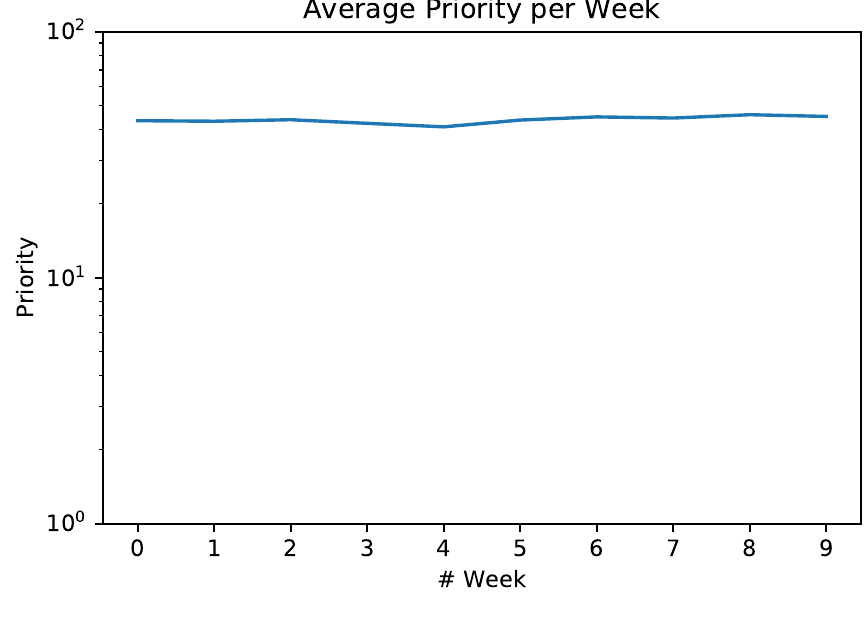
Figure 7. Average Priority per Week.